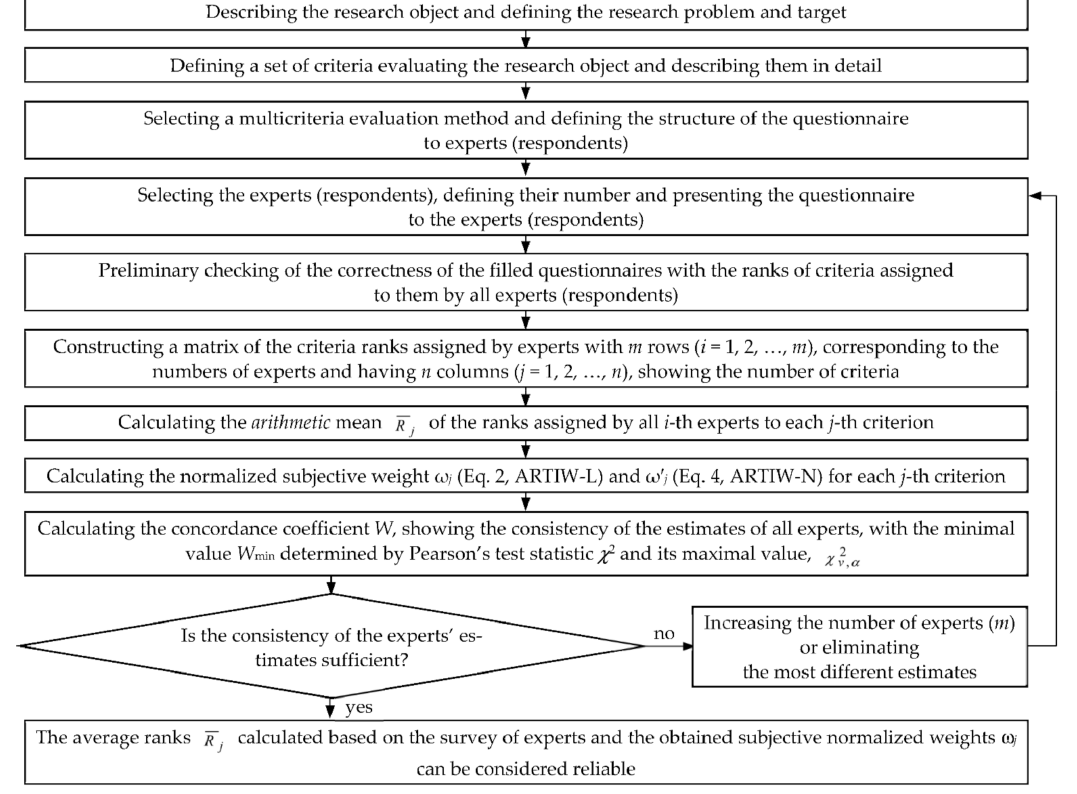
Figure 1. The algorithm of ARTIW-L and ARTIW-N methods of the average rank transformation into weight used for calculating normalized subjective weights of the criteria describing the research